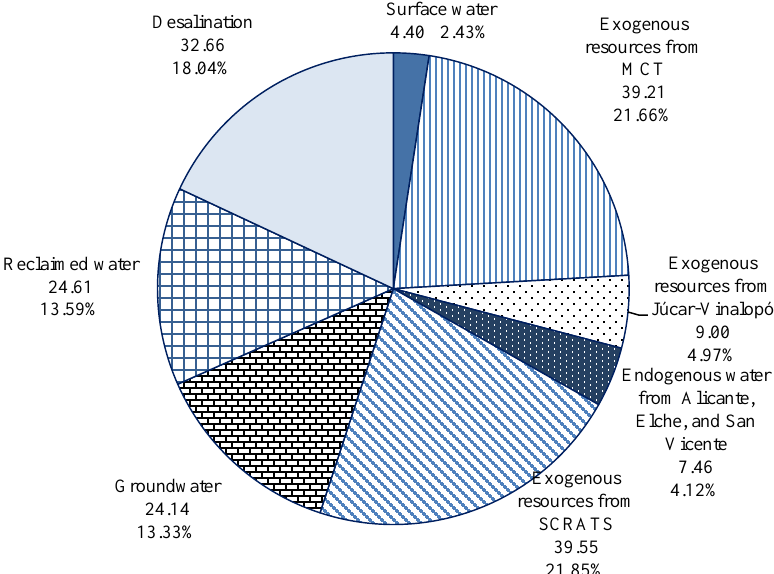
Figure 7. Water inputs in the study area, shown in hm³/year and percentage. Source: own elaboration relying on previous sections.